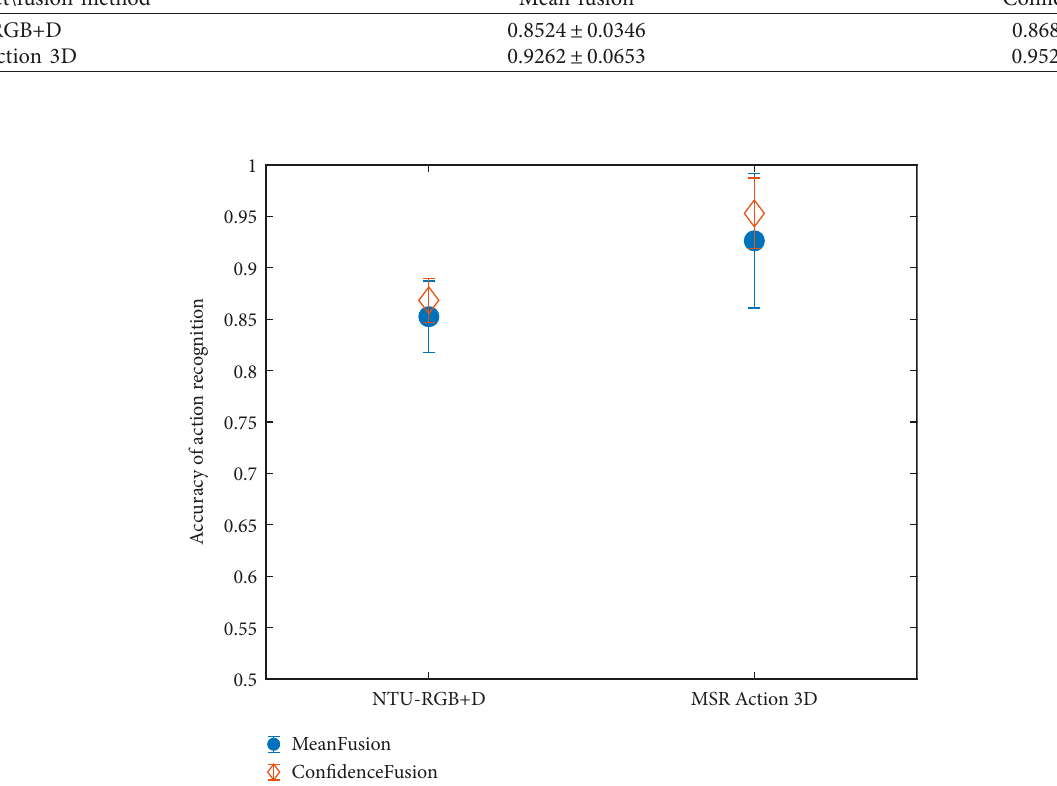
Figure 8: Accuracy of action recognition with different fusion